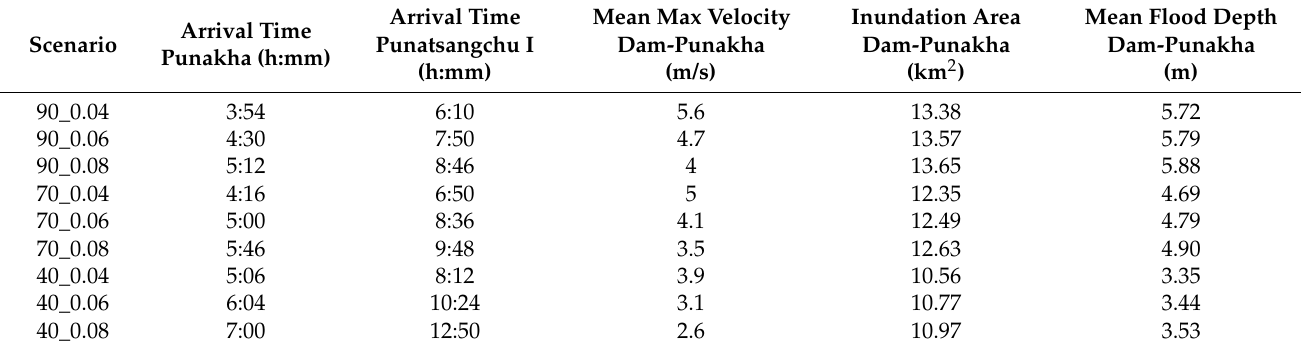
Table 2. Arrival times, inundation areas, mean inundation depths, and mean maximum velocities of the GLOF scenarios.